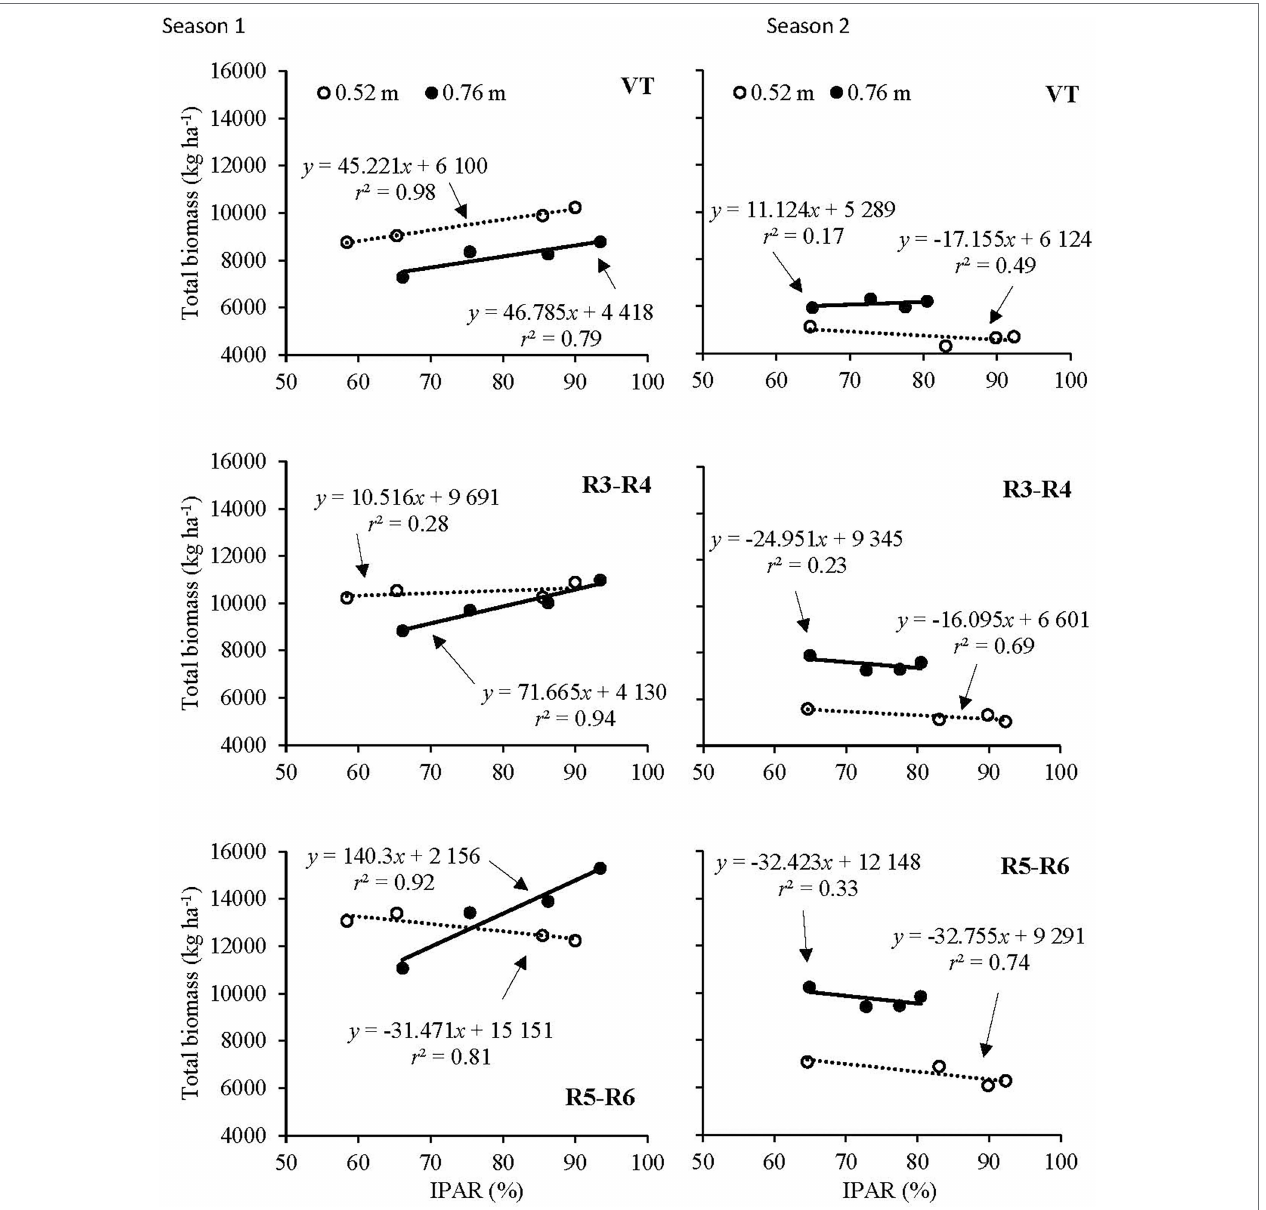
FIGURE 3 | Relationship of total biomass to IPAR at the tasseling (VT) development stage, the linear development phase of kernel filling (R3–R4) and physiological maturity (R5–R6) development stage at the 0.52 and 0.76 m row spacings in Season 1 (left) and Season 2